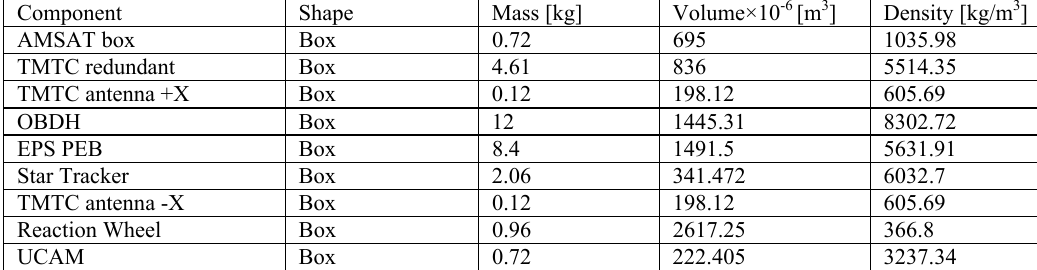
Table A5 Internal equipment thermo-physical